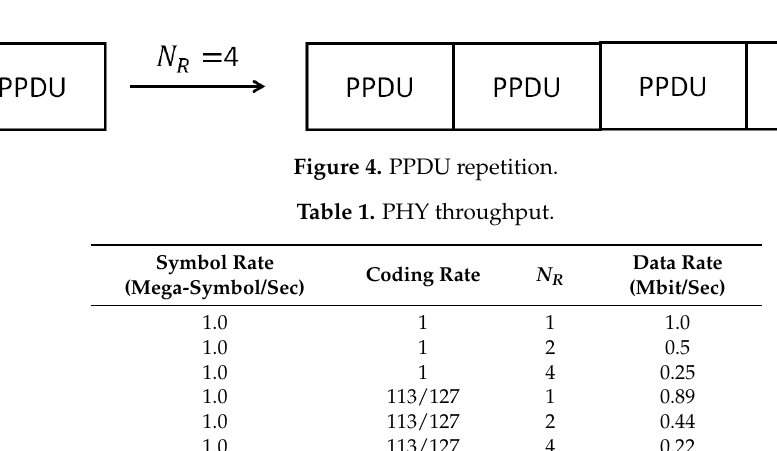
Figure 3. PPDU structure.